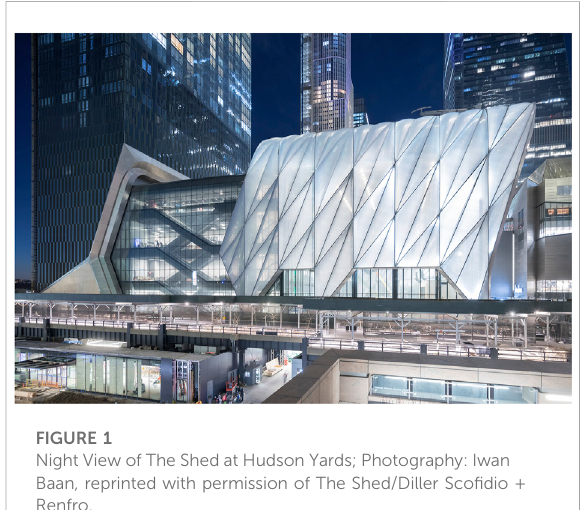
FIGURE 1 Night View of The Shed at Hudson Yards; Photography: Iwan Baan, reprinted with permission of The Shed/Diller Sco fi dio +